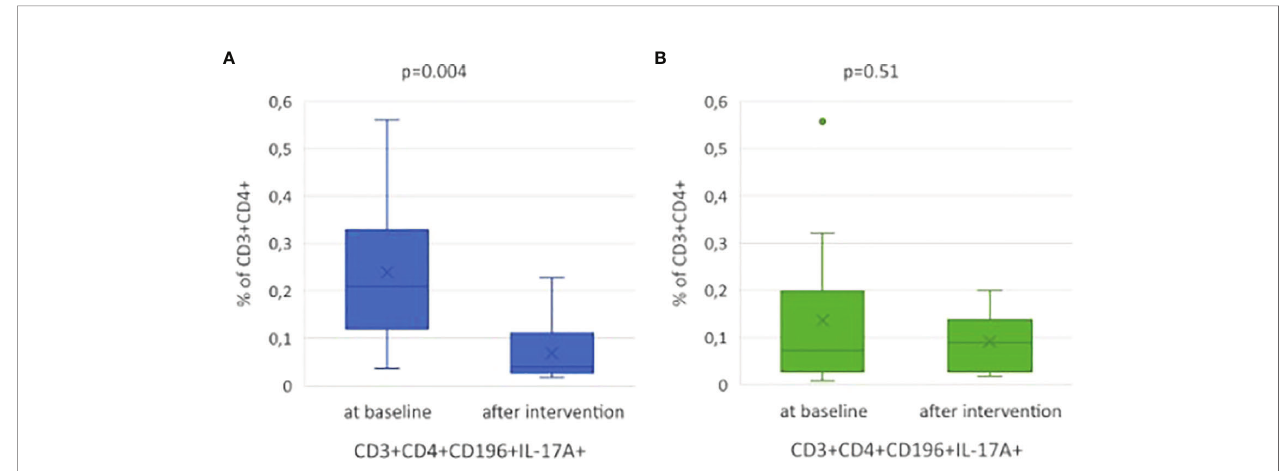
FIGURE 3 | (A) Statistical analysis amount of Th17 cells (%) in the study subgroup at baseline and three months later after BMI reduction. (B) Statistical analysis of Th17 cells frequency in the study subgroup at baseline and after intervention, without BMI reduction. All box plots represent the minimum, the fi rst quartile, the median, the mean, the third quartile and the maximum. Dots represent